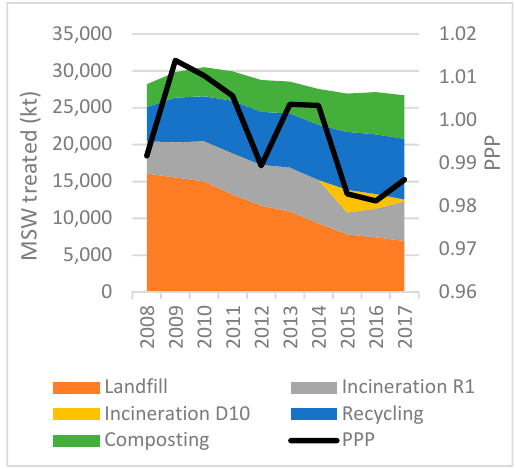
Figure 24. Waste treatment method and PPP in Italy 2008–2017 (EUROSTAT 2019b, 2019c).